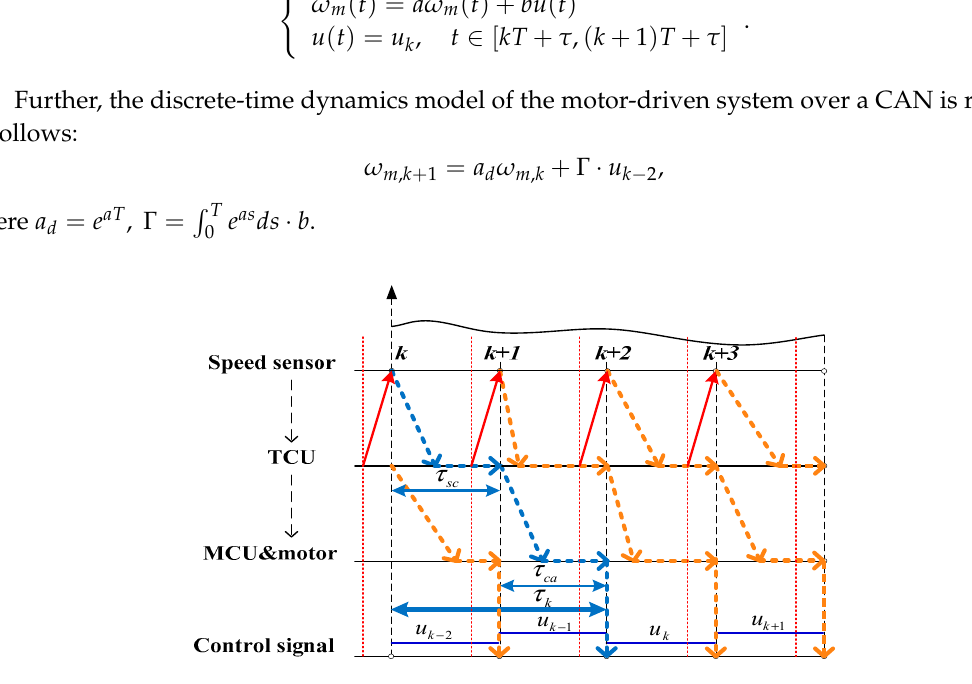
Figure 2. Scheduling-based delays in the loop.